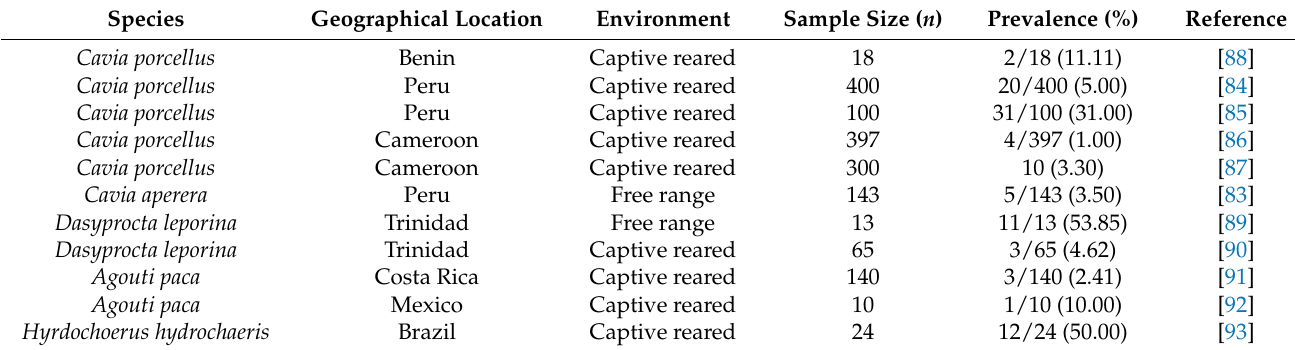
Table 1. Prevalence of Trichuris spp. in different locations in neo-tropical